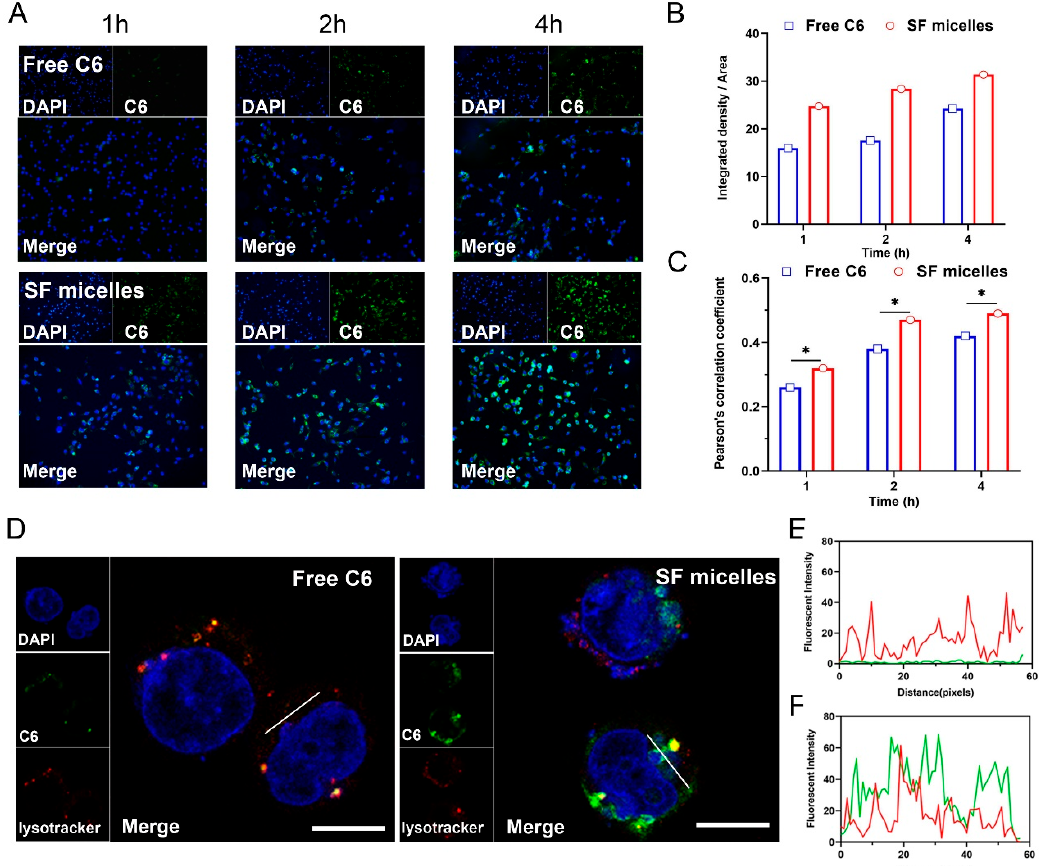
Figure 3. Interaction between SF micelles and TC-1 cells. ( A ) Fluorescent microscopic photographs of TC-1 cells after 1 h, 2 h or 4 h incubation with Free C6 and C6-labeled SF micelles (green). The nucleus was stained with DAPI (blue). ( B ) The Average fluorescence intensity (fluorescence intensity/Area) and ( C ) corresponding co-localization profiles of photographs in Figure A were calculated by Image J software (The Pearson’s correlation coefficient represents the co- localization between the nucleus (blue) and Free C6 and SF micelles (green). Higher values represent a stronger degree of co-location). ( D ) Representative intracellular localization images of C6-labeled SF micelles incubated with TC-1 cells with 4 h. The lysosomes stained by Lysotracker were red and the nucleus stained by DAPI were blue. The bar is 20 μ m. ( E ) The corresponding co-localization profiles of Free C6 and ( F ) SF micelles in Figure D were calculated by Image J software. The red line stood for lysosomes, and the green line stood for micelles. Significance criteria: * p < 0.05.